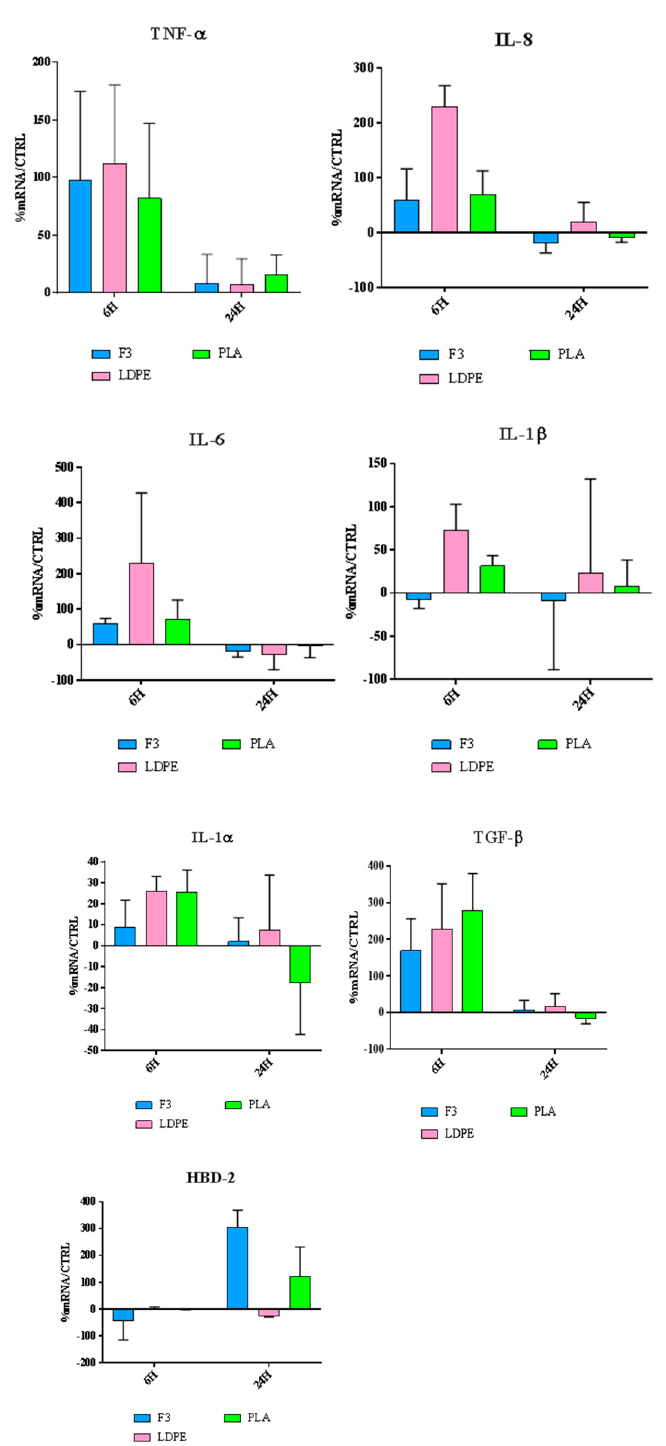
Figure 12. Relative gene expression of proinflammatory cytokines and HBD-2 in HaCaT cells. Data are expressed as mean ± SD as a percentage of the relative mRNAs in each group compared to plain HaCaT cells as a control.